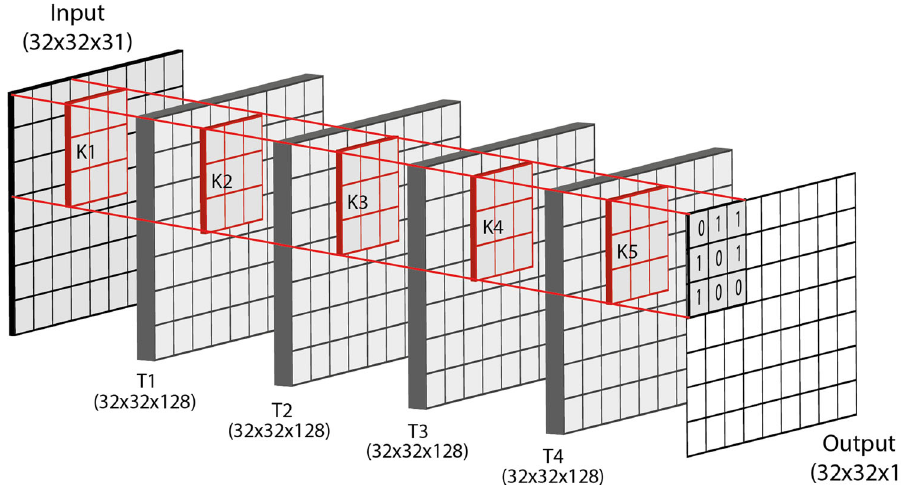
Fig. 6 Model structural diagram. Model structural diagram showing the input, 3 × 3 kernel layers (K1 – K5), each transformation passed forwards (T1 – T4) and the output, with all dimensions labelled.